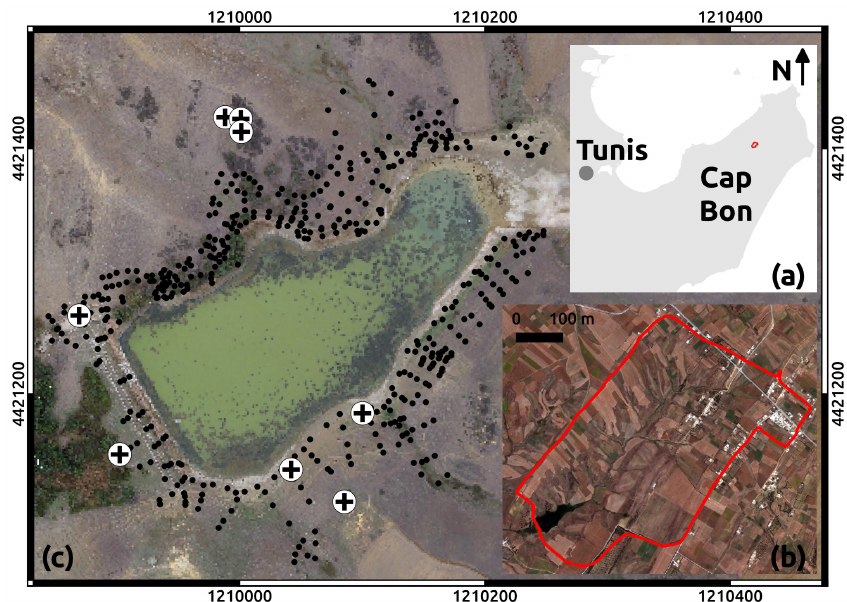
Figure 1. Location of the Kamech test site and ground-truth data used in the SfM process. (a) Location of the Cap Bon peninsula, in north- eastern Tunisia; Kamech is marked in red. (b) Close-up of the Kamech catchment, 2.63km 2 , delineated in red; its outlet is an artificial lake, visible in the south-east of the catchment. (c) Close-up of the available ground-truth data around the lake; scale is given by the external graduations (projection UTM, EPSG:32632); the dam is the linear feature visible on the south-eastern side of the lake. The ground-truth data set is composed of ground control points (GCPs, crosses), which are used to give spatial references to the image data set, and validation points (black dots), which are used to independently validate the DEM computed from the image data set.